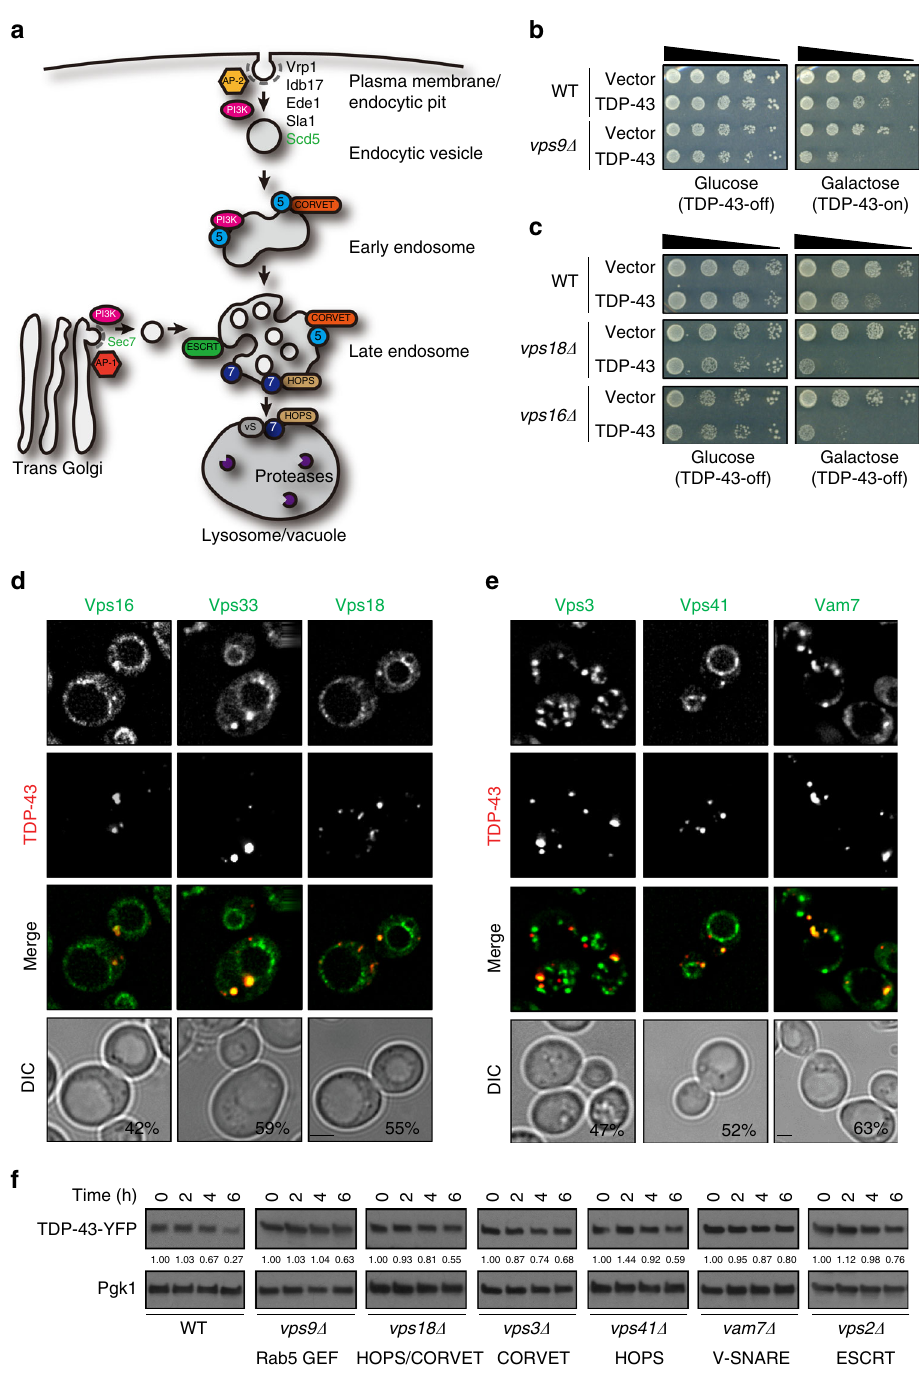
Fig. 4 Endocytosis affects TDP-43 toxicity and turnover in yeast. a Schematic of endocytosis and trans-Golgi vacuolar traf fi cking, highlighting all genes/ complexes tested in yeast; green text (Sec7, Scd5) indicates GFP co-localization experiments only conducted. b WT and vps9 Δ (Rab5 GEF) strains expressing vector or TDP-43-YFP. c WT, vps18 Δ , and vps16 Δ strains expressing vector or TDP-43-YFP. d , e Strains expressing indicated GFP-tagged proteins were transformed with TDP-43-mRuby2. % value indicates co-localization of TDP-43-mRuby2 foci with GFP-tagged proteins. Scale bar = 2 µ m. f Turnover of TDP-43-YFP in WT and indicated null strains; conducted as in Fig.